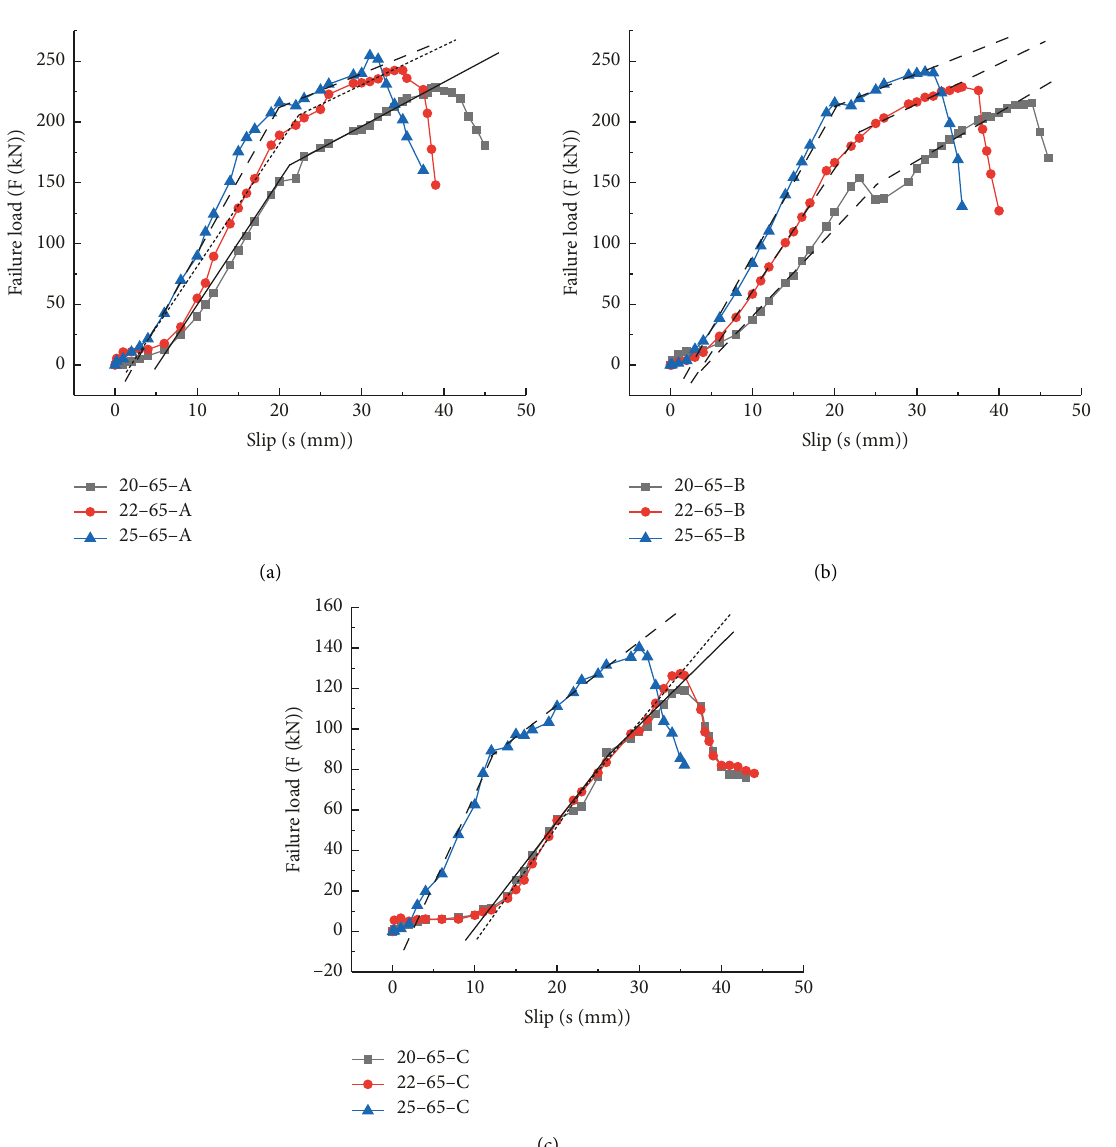
Figure 6: Influence of aperture ratio on specimen properties. (a) Grout A. (b) Grout B. (c) Grout